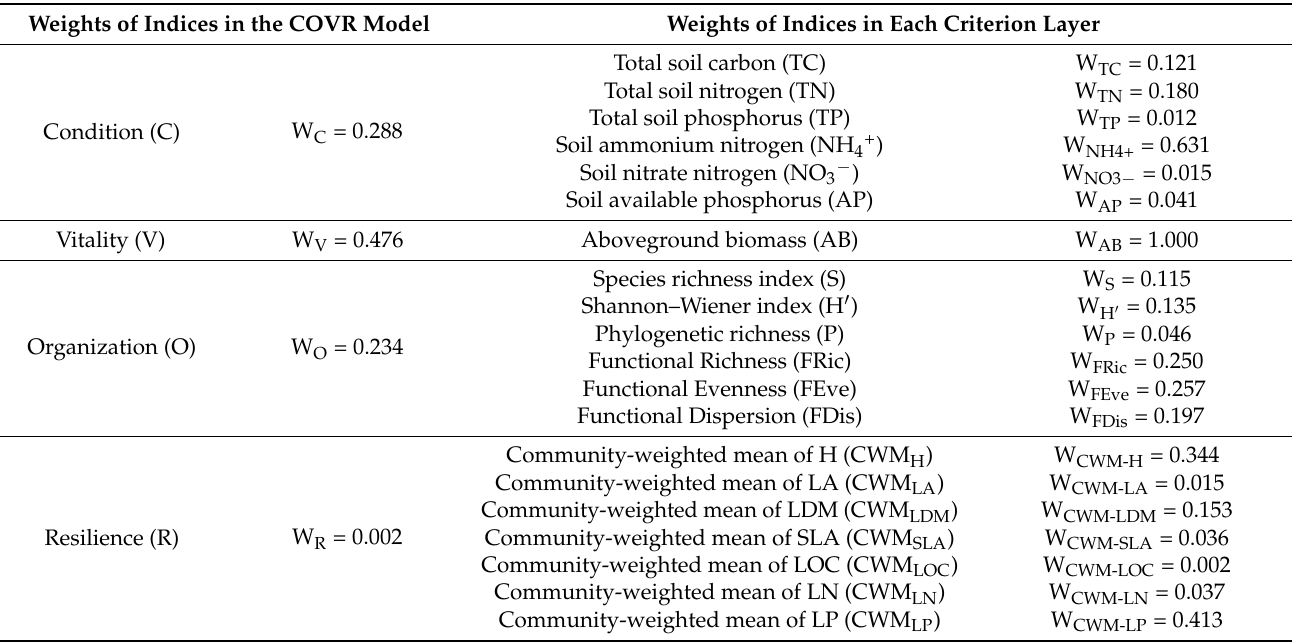
Table 2. The weights of each criterion layer and indices in the CVOR model.